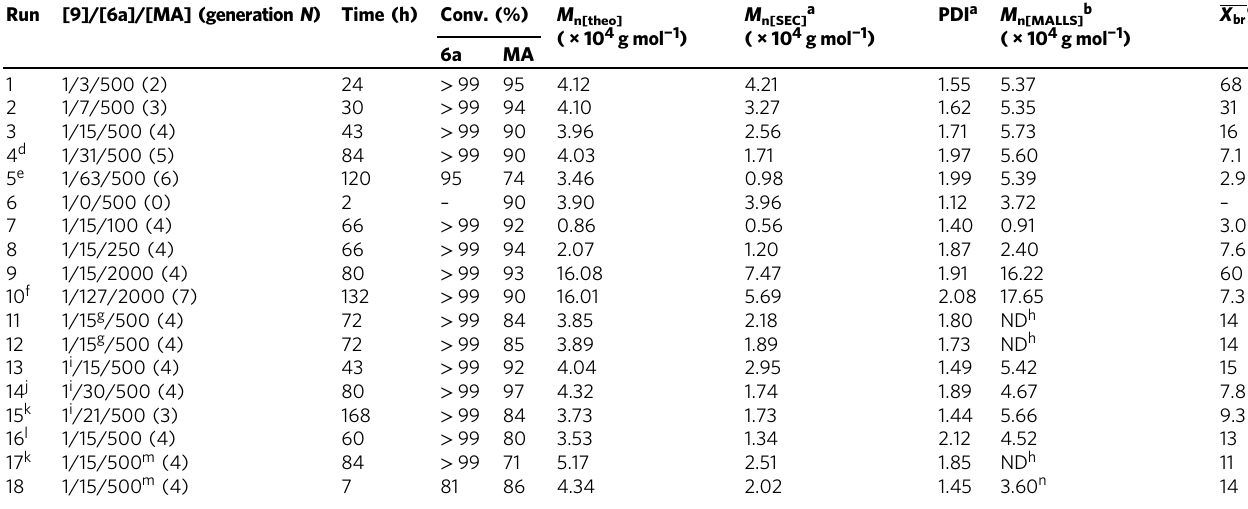
Table 1 Synthesis of branched polymers by the copolymerization of 6a and acrylate monomers via organotellurium-mediated radical polymerization